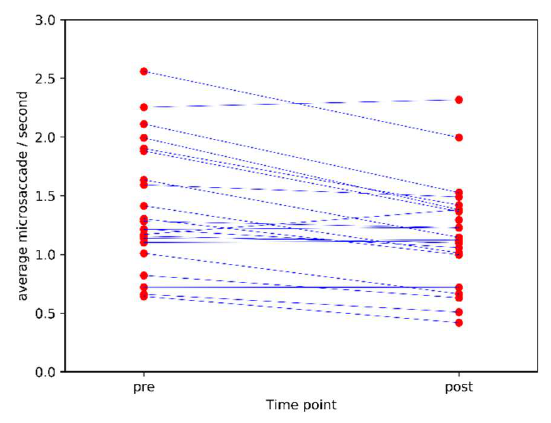
Figure 1: Mean microsaccade count/second pre and post caffeine administration (lines connect measurements from the same individual pre and